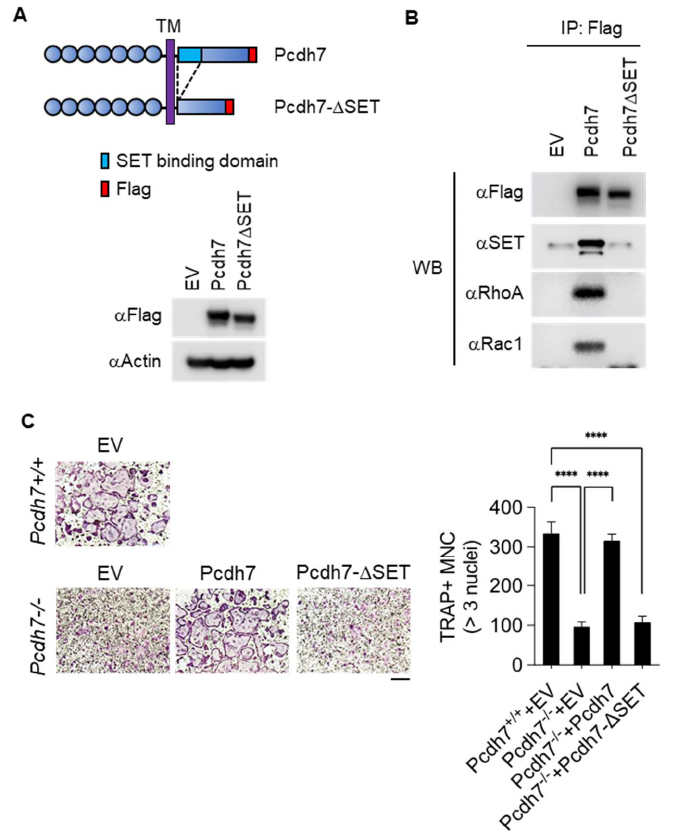
Figure 3. Pcdh7-deficiency is rescued by full-length Pcdh7 but not by Pcdh7 ∆ SET. ( A ). Schema of Pcdh7 wild-type and SET-binding domain deletion mutants (Pcdh7 ∆ SET). Both constructs were Flag-tagged at the C-terminus (top). Protein expression was confirmed by Western blotting with an anti-Flag antibody (bottom). ( B ). Coimmunoprecipitation of Pcdh7 with SET, RhoA, and Rac1. Pcdh7 − / − BMMs retrovirally transduced with the indicated vectors were lysed and immunoprecipitated with anti-Flag antibody, and Western blotting was performed with the indicated antibodies. ( C ). Osteoclast differentiation rescued by retroviral transduction of Pcdh7 but not by Pcdh7 ∆ SET in Pcdh7 − / − BMMs. BMMs were retrovirally transduced with empty vector (EV) or Flag-tagged Pcdh7 expression vectors followed by culture with M-CSF + RANKL for three days. The number of TRAP + multinucleated cells (3 nuclei or more per cell) is shown. The scale bar represents 100 µ m. Data are shown as the mean ± S.D. **** p <